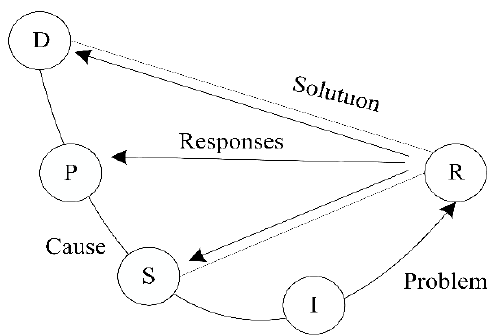
Figure 1. Schematic of DPSIR model.